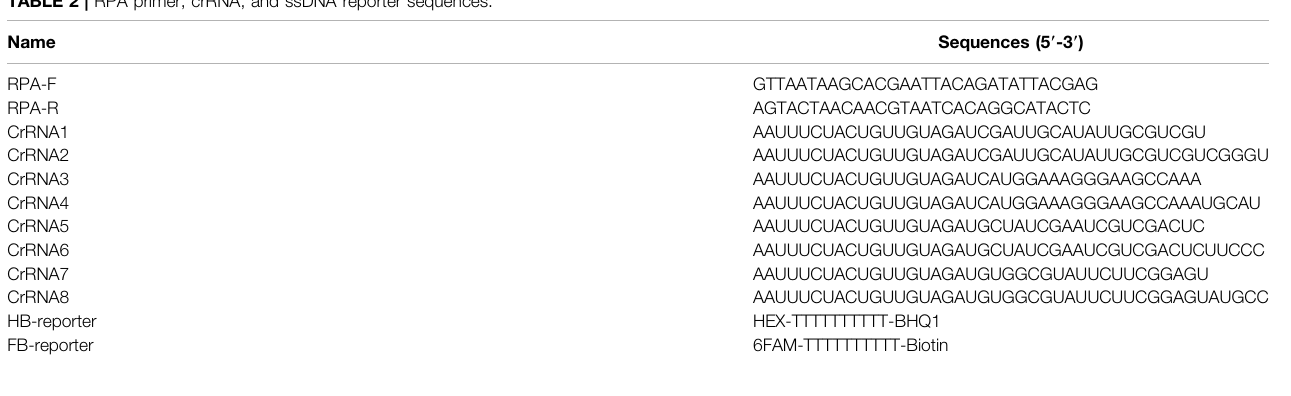
TABLE 2 | RPA primer, crRNA, and ssDNA reporter